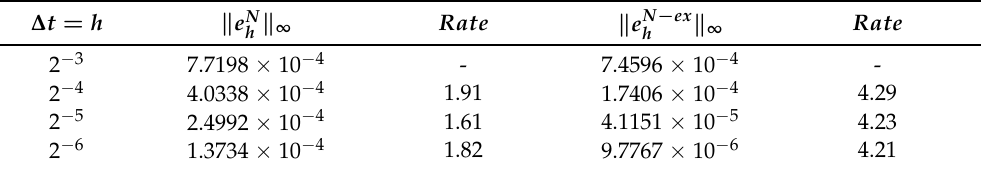
Table 2. Error behaviors and rate for the Crank-Nicolson scheme and exact solution for Example 1 with α = 0.8 at time T =